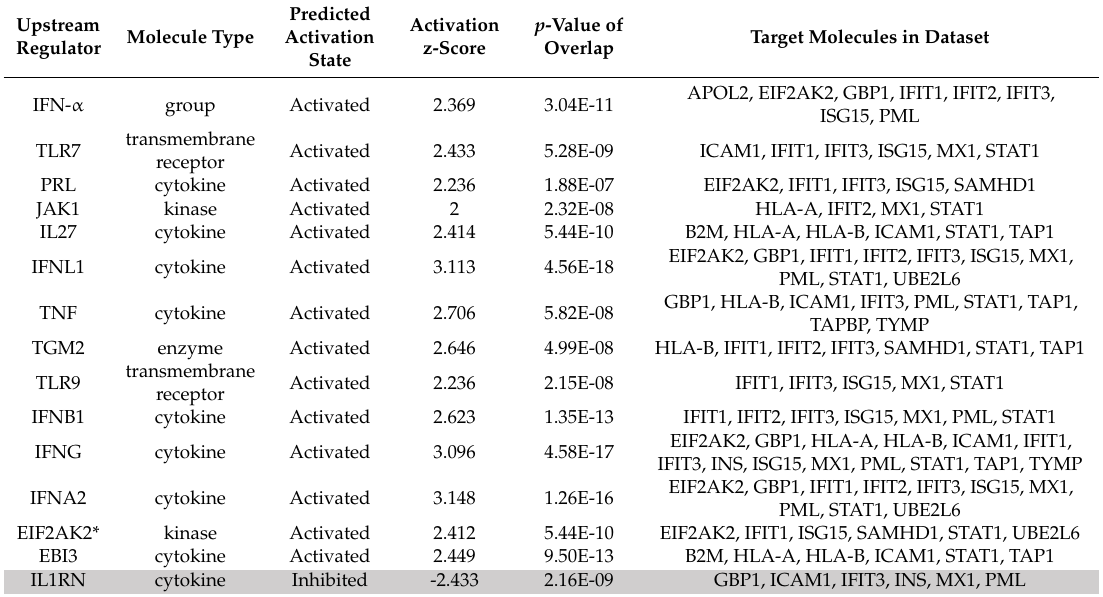
Table 2. Proteomics. Di ff erentially regulated genes in CVB4-infected SC- β cells compared to primary beta cells (results shown are for 72 h post